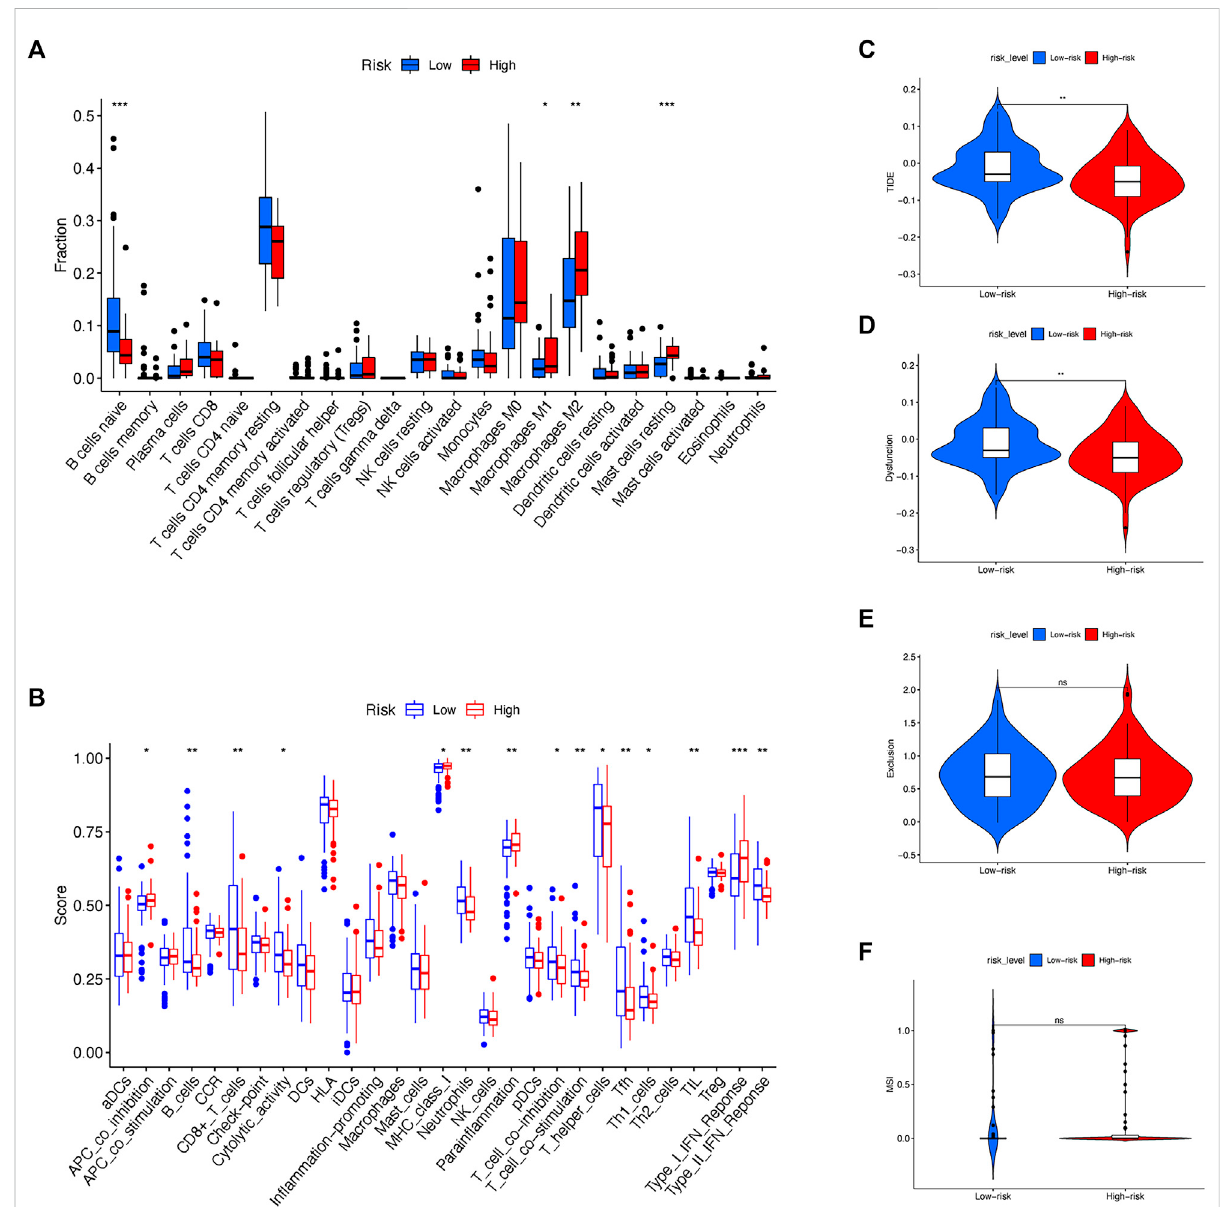
FIGURE 6 Exploration of immune landscape between low- and high-risk subgroups. (A) CIBERSORT algorithm evaluated the level of 22 major immune cellsbetweenrisksubgroups. (B) ssGSEAassessedtheextentofmainimmunecellsandactivations. (C)